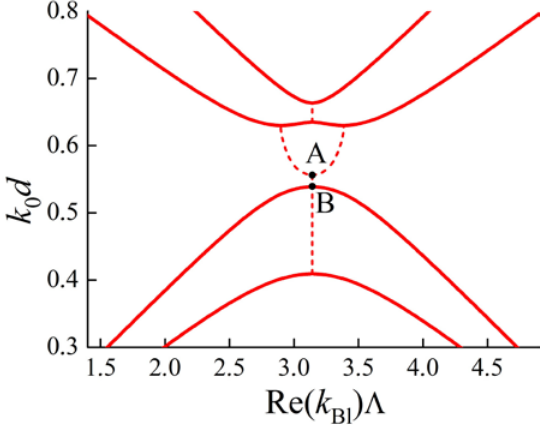
A steadily moves along the solid curves to the left or right and may even move up (across the point B) along the Brillouin zone boundary Figure 8. Frequency dependence of all layers, 2 d Λ = is a PC period). The solid lines correspond to propagating waves, the dashed lines correspond to BGs.